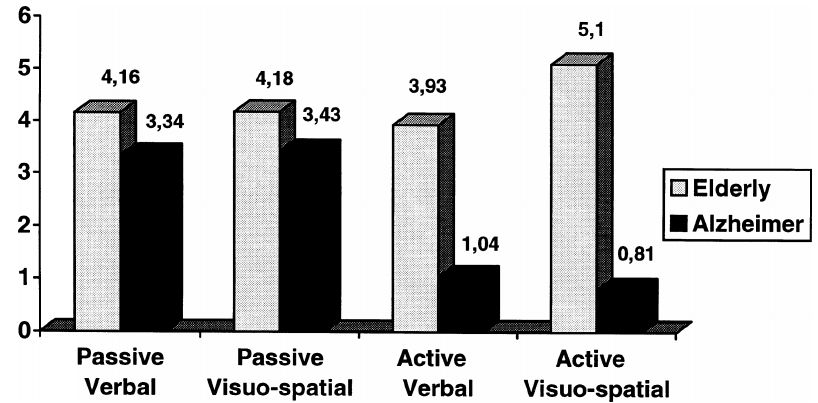
Fig. 1. Mean performance (i.e., span values) of elderly and DAT subjects in the four tasks.